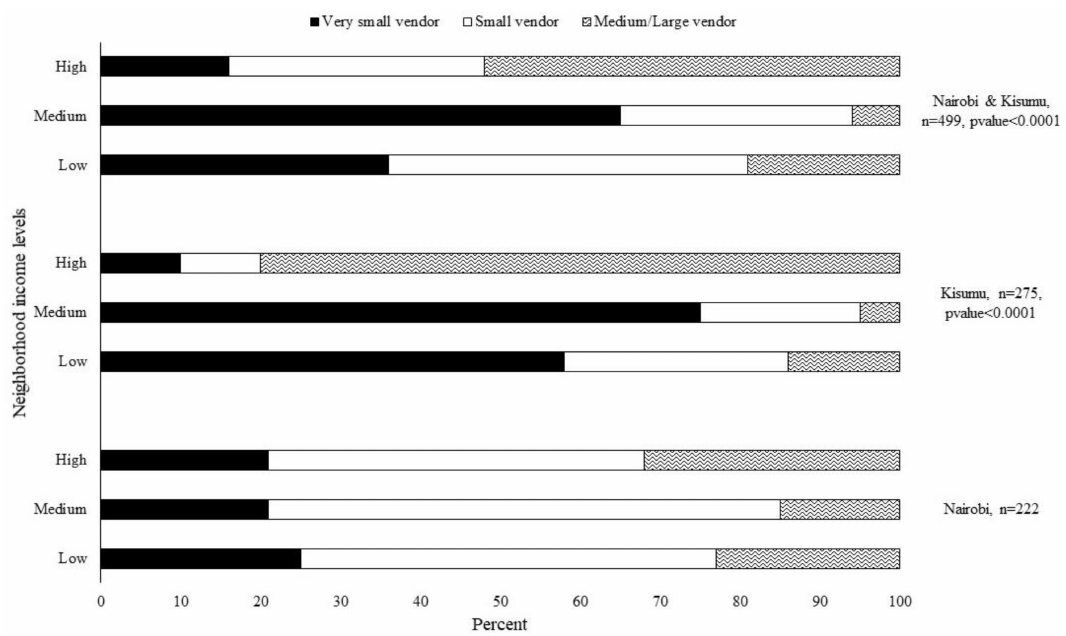
Figure 1. Percentage of very small, small and medium/large-sized food places in low, medium and high income neighbor- hoods in Nairobi and